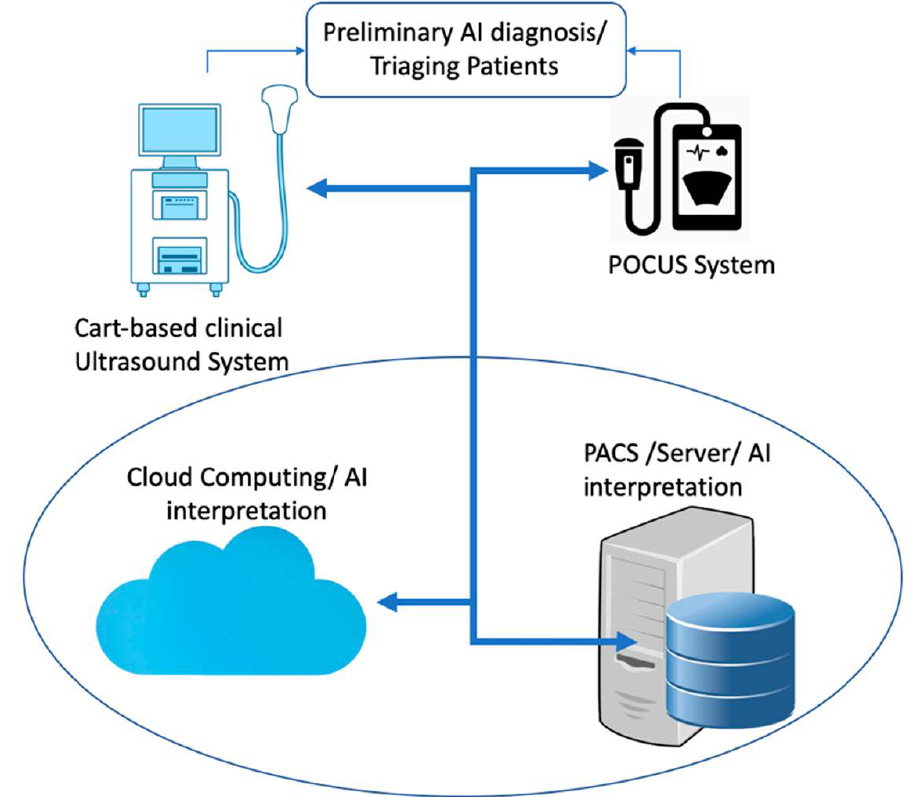
Figure 6. A schematic diagram of AI (artificial intelligence) interpretation of echocardiography images for preliminary diagnosis and triaging patients in emergency and primary care clinics. POCUS: point of care